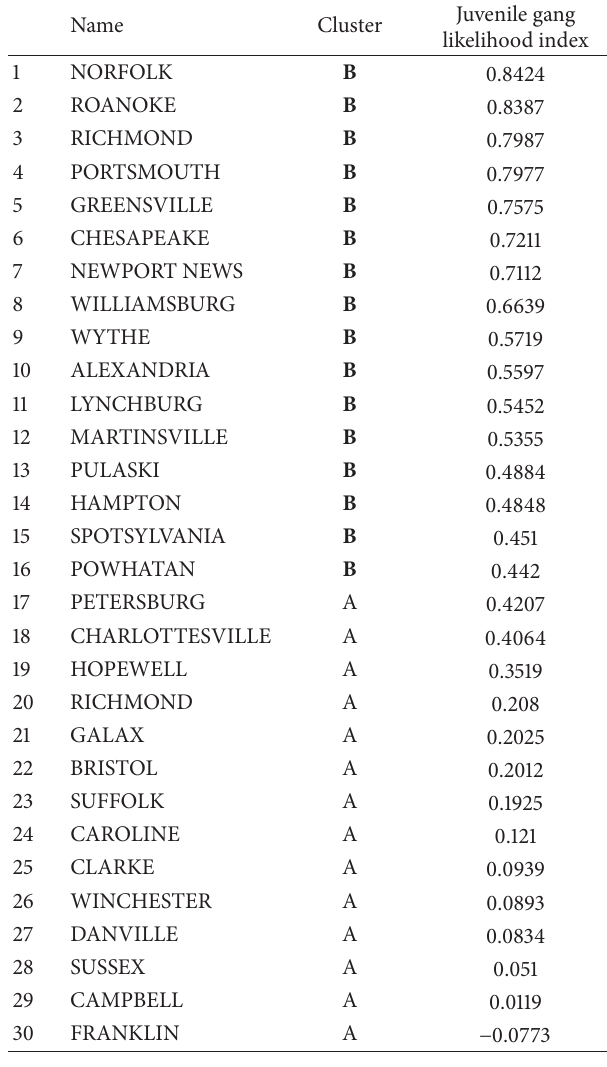
Table 10: Likelihood index and clustering for juvenile